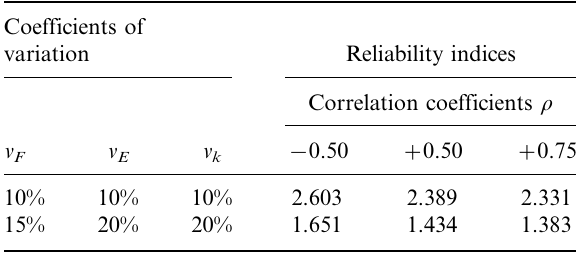
Table 7. Reliability index calculated for the examples of correlated random variables